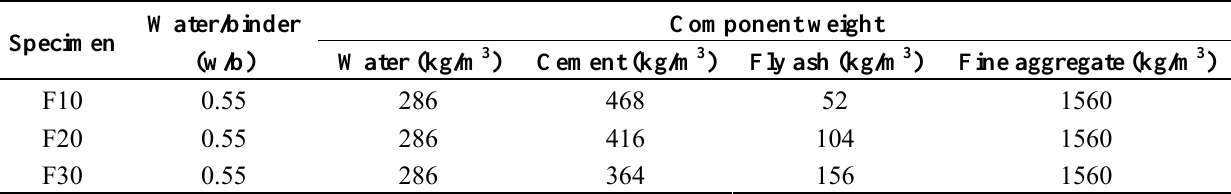
Table 5. Mix design of cement with fly ash—Type F specimen.